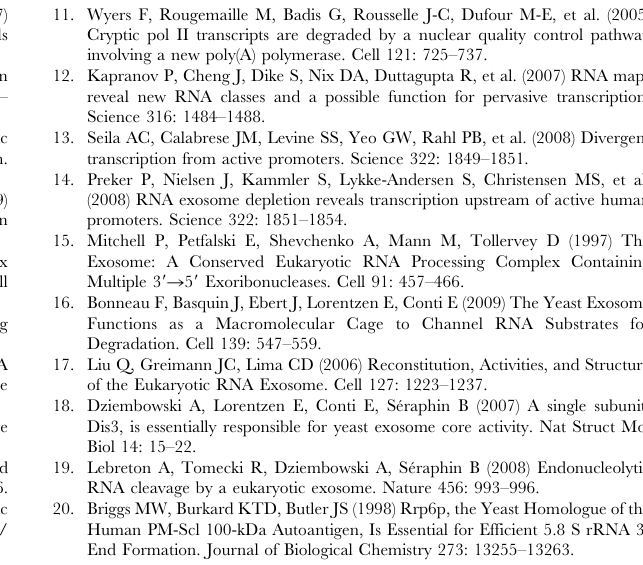
Table S3 Expression profiling of known mature miRNAs in the